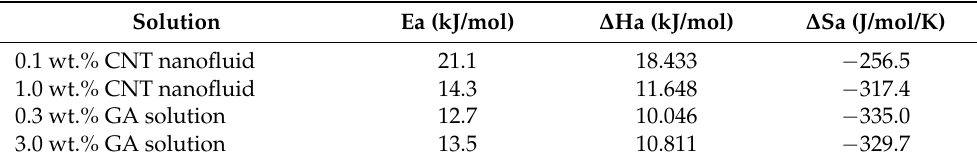
Figure 5. Log corrosion rate (log CR) versus (1000/T) for 316L stainless steel in 0.1 wt.% and in 1.0 wt.% CNTs–water nanofluids. Table 6. Calculated values of thermodynamic parameters for 316L stainless steel tested in 0.1 and 1.0 wt.% CNTs–water nanofluids.